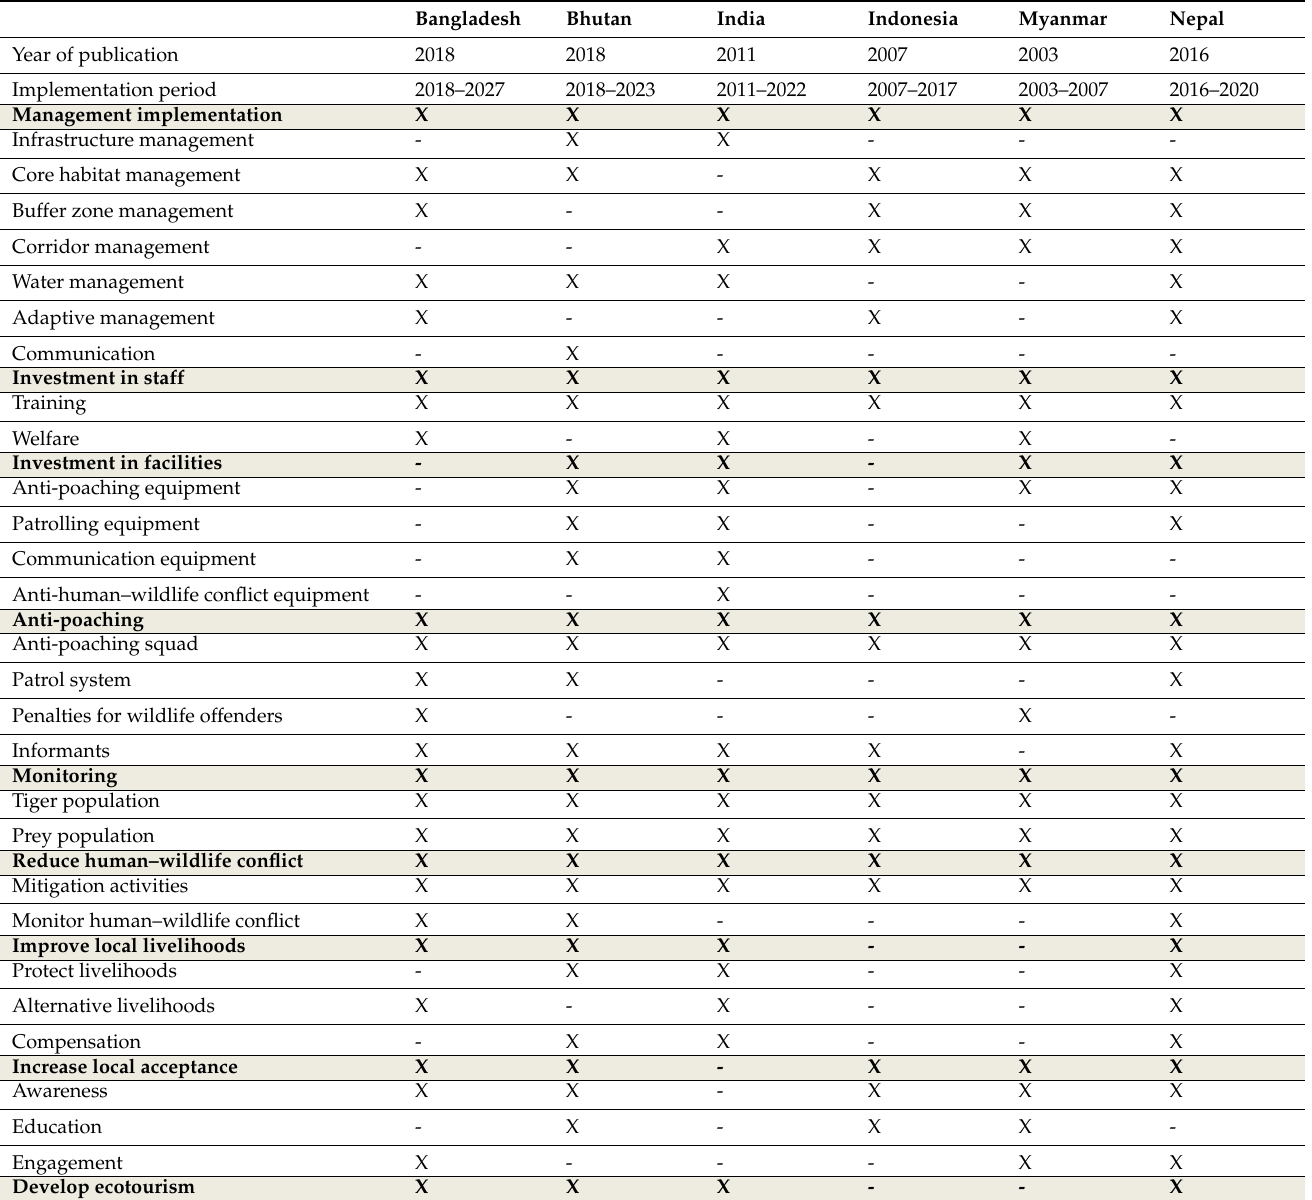
Table 1. Overview of what focal areas of the Global Tiger Recovery Programme and ITHCP are addressed in the NTAPs for each ITHCP category. Shaded cells with bold text indicate the different clusters of focal areas. Underneath the shaded rows, the clusters are broken down in more specified focal areas. All focal areas marked with an “X” are addressed